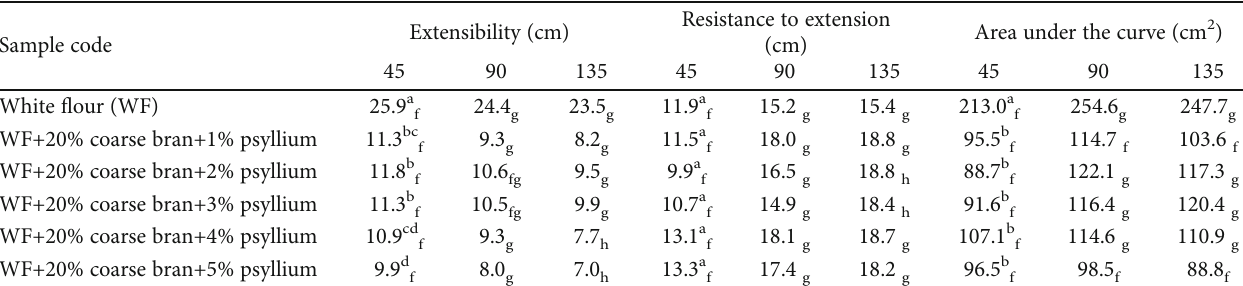
Table 12: Extensograph characteristics of dough made from fl our, coarse bran, and psyllium